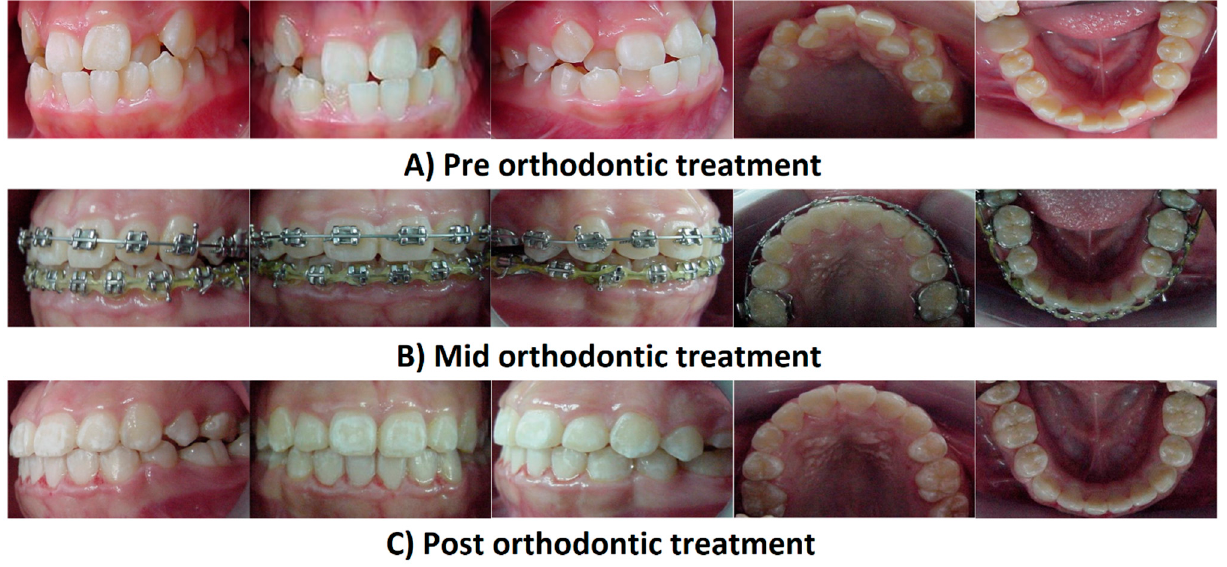
Figure 4. Photographs of the fixed appliance for orthodontic treatment using shape-memory P.U. wire. ( A ) Pre-orthodontic treatment; ( B ) Mid-orthodontic treatment; and ( C ) Post-orthodontic treatment.